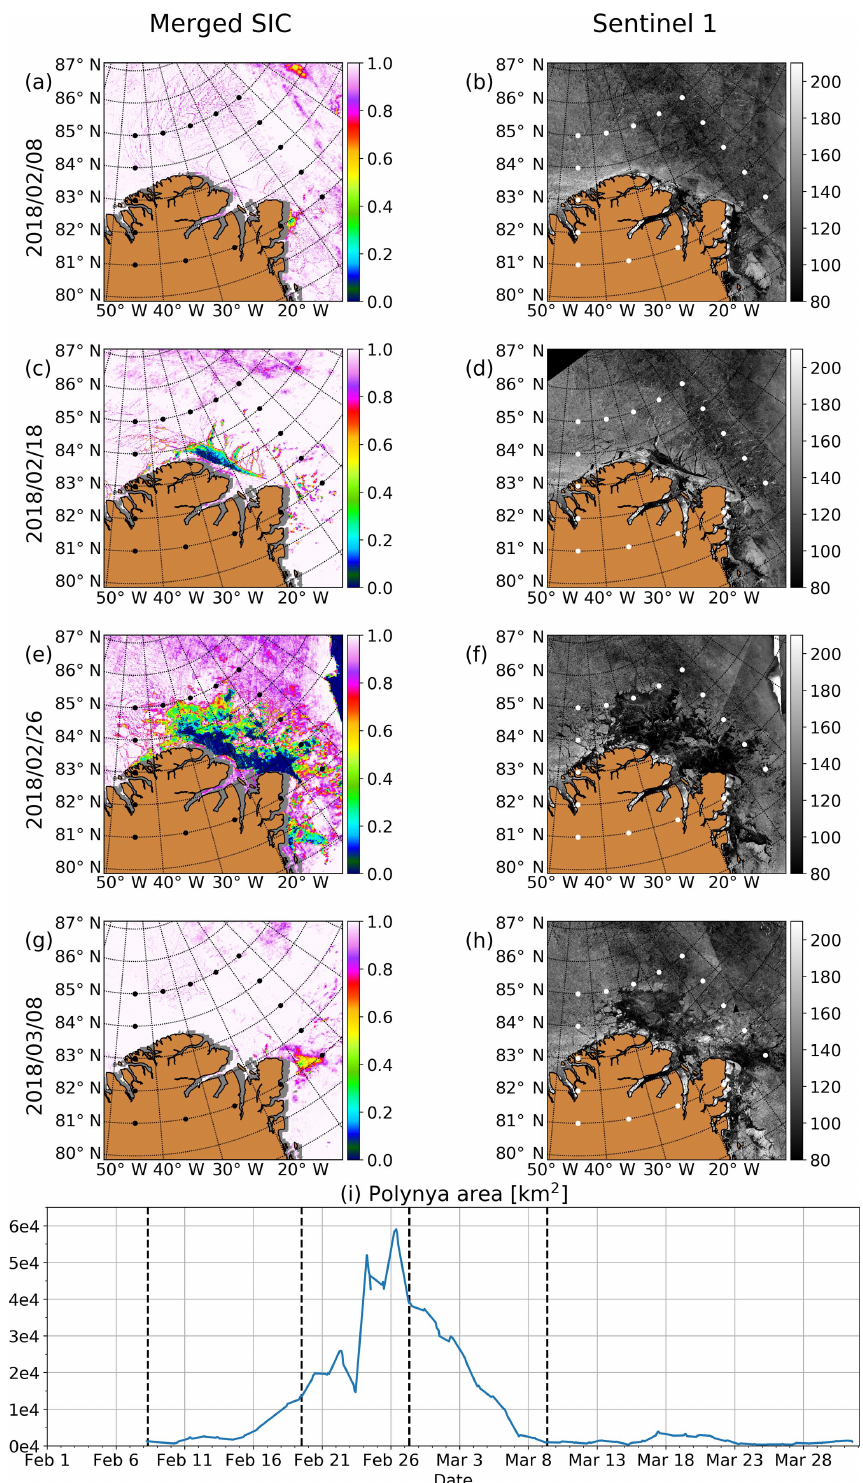
Figure 5. (a, c, e, g) Merged SIC before, at the beginning, at the maximum and after the refreezing of the polynya. The MODIS–AMSR2 pairs were acquired at 07:50 and 07:44 on 8 February, at 11:45 and 11:39 on 18 February, at 09:15 and 09:11 on 26 February and at 11:30 and 11:28 on 8 March, respectively. All times are UTC. (b, d, f, h) Corresponding Sentinel-1A/B daily mosaics. The colour bar units are greyscale values. (i) Time series of the polynya area. The polynya area is calculated as the sum of the open water fraction (1 – merged SIC) in the map area, multiplied by the respective grid cell size. All available granules are shown. The acquisition times of panels (a) , (c) , (e) and (g) are marked by the vertical dashed